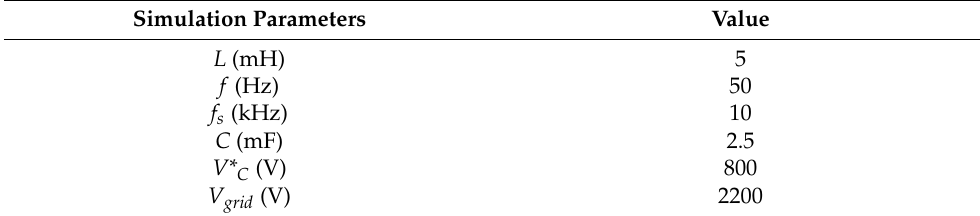
Table 1. PSIM simulation